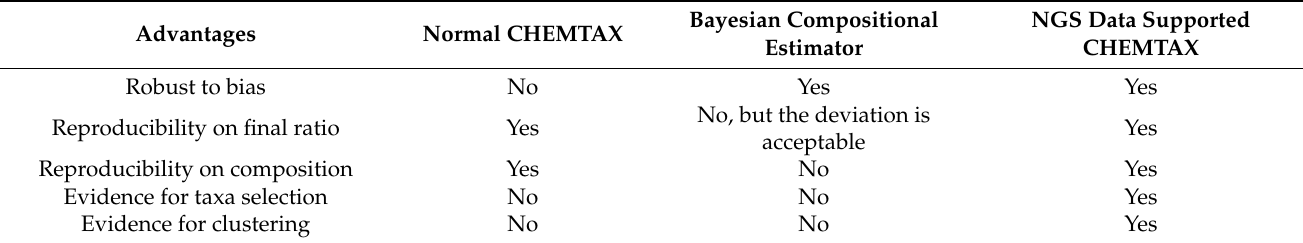
Table 7. Advantages and disadvantages of chemotaxonomic quantification